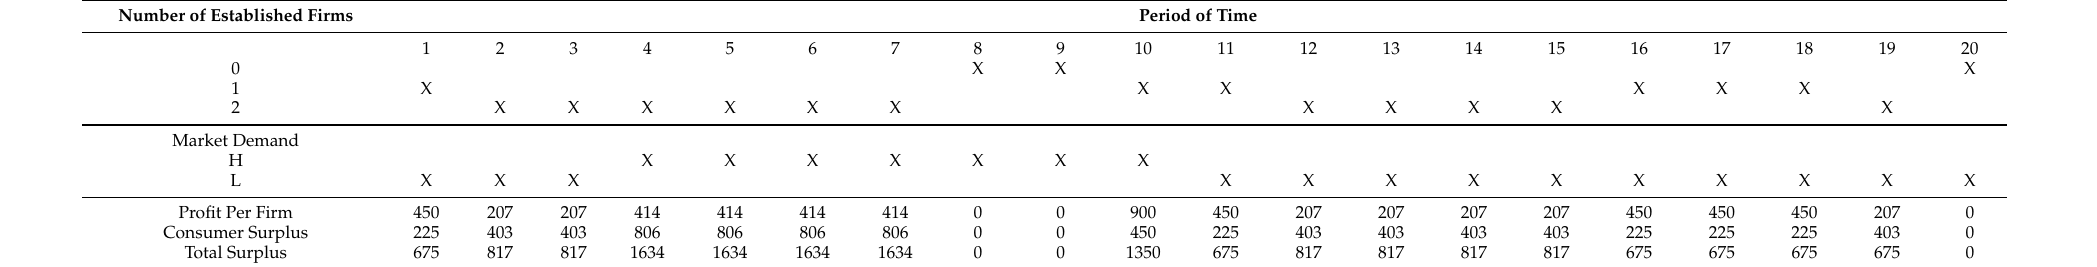
Table 11. Two active firms in the Cournot framework with the initial state of the system ( 1, L ) .